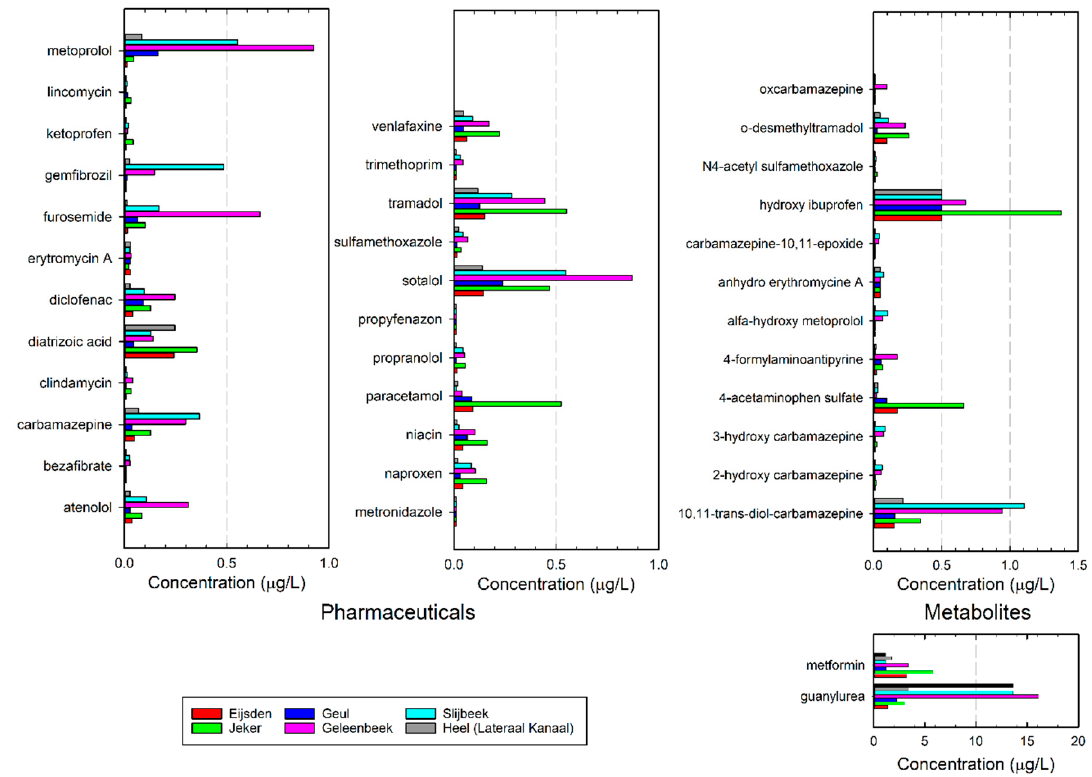
Figure 3. Average concentrations (n = 4) of pharmaceuticals and their metabolites detected in the River Meuse and its tributaries.